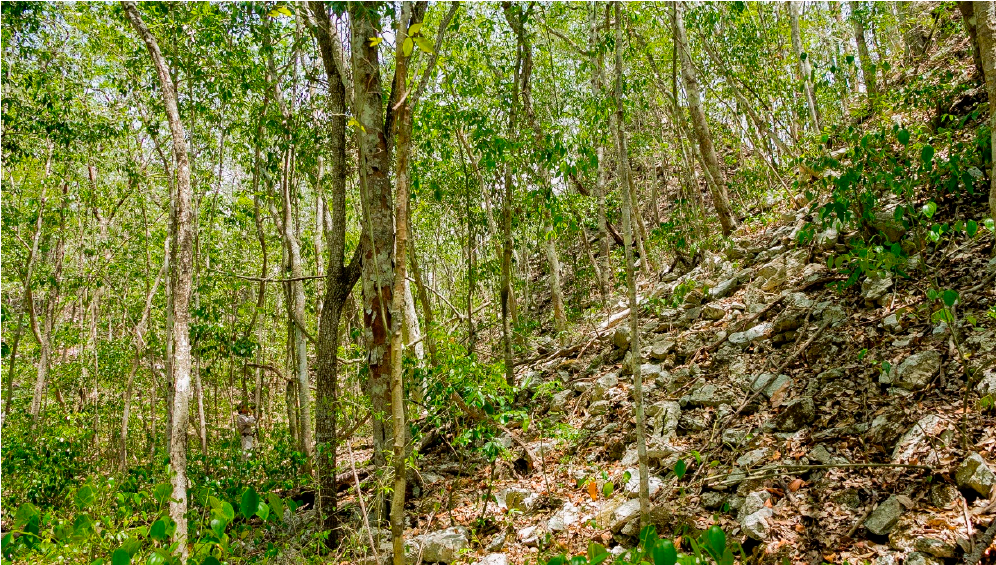
Figure 3. A view of a palace with two turrets and an adjacent ball court, located in the Chactún’s south-eastern group. Typical vegetation cover is broad-leafed, semi-deciduous tropical forest. For a sense of scale, note a hardly visible human figure (prof. Ivan Šprajc) in the lower left corner. Photo by Žiga Kokalj.